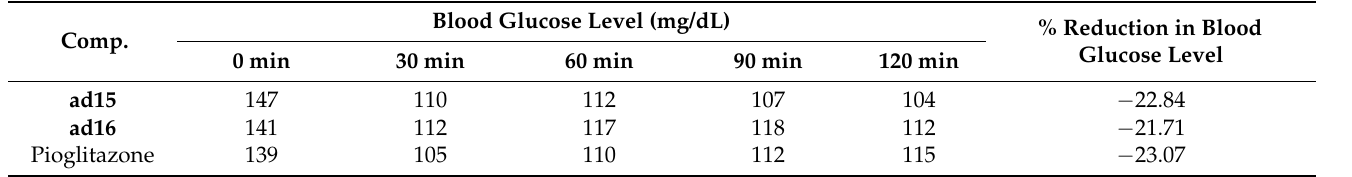
Table 36. Antidiabetic potential of the compounds ( ad15 – ad16 ) using a sucrose-loaded model in rats.